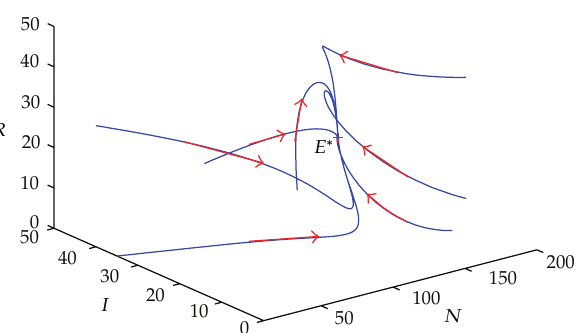
Figure 5: The phase diagram of system (cid:5) 1.4 (cid:6) when I 0 (cid:7) 40, A (cid:7) 100, β 1 (cid:7) 0 . 02, β 2 (cid:7) 0 . 01, γ (cid:7) 0 . 01, d (cid:7) 0 . 9, (cid:4) (cid:7) 0 . 01, r (cid:7) 1 . 5, p